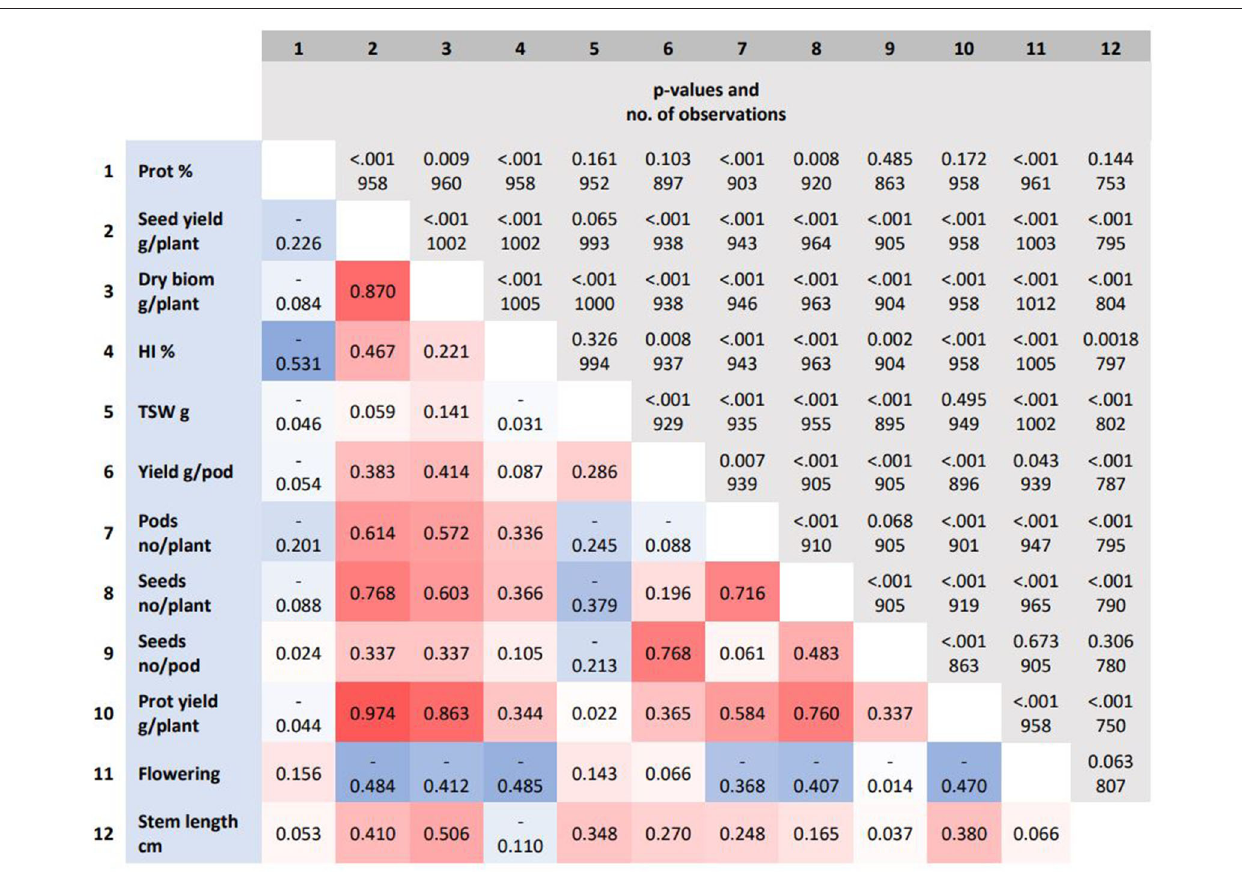
FIGURE 6 | The Pearson correlation coefficients for yield and protein-related traits are represented by the colored background, while p -values and the number of observations are represented by the gray background. Flowering indicates first flowering. prot, protein; biom, biomass; HI, harvest index; TSW, thousand seed